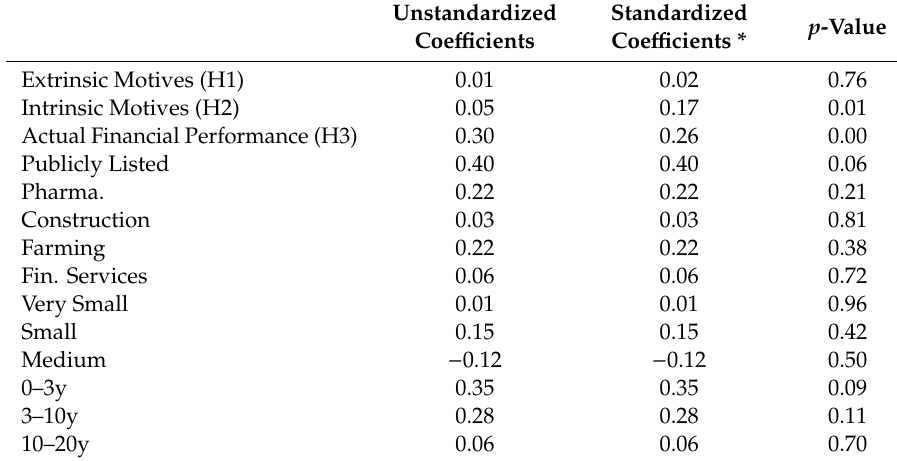
Table 6. This table presents the multiple regression results for testing the three main hypotheses by regressing the below independent variales on CSR the dependent